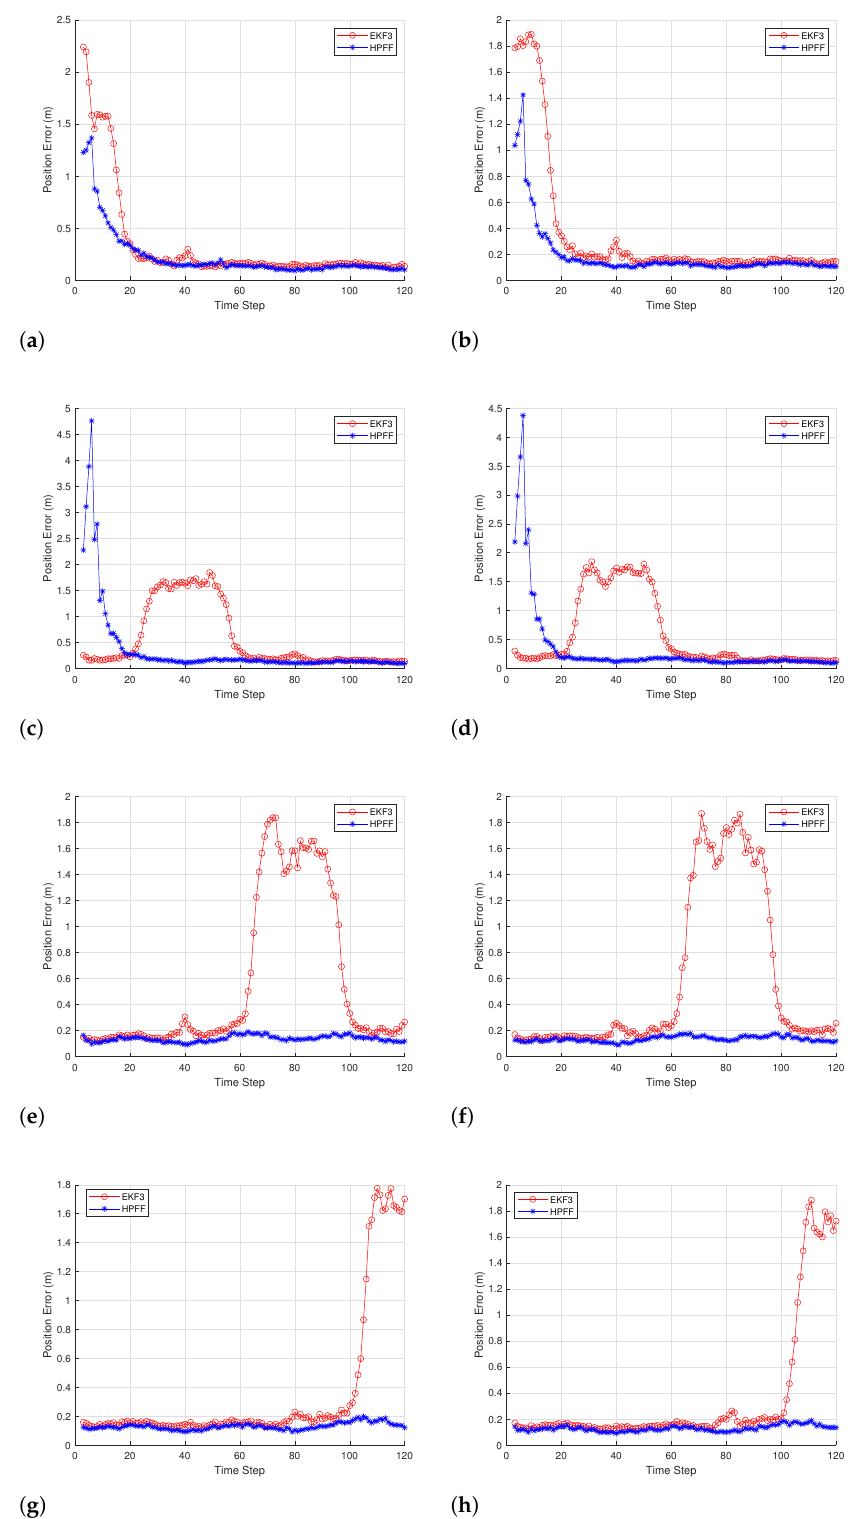
Figure 9. RMS position errors of indoor localization using HPFF and EKF3 under constant NLOS conditions in which the transmitter (FN) in a NLOS was ( a ) FN1, ( b ) FN2, ( c ) FN3, ( d ) FN4, ( e ) FN5, ( f ) FN6, ( g ) FN7, and ( h )